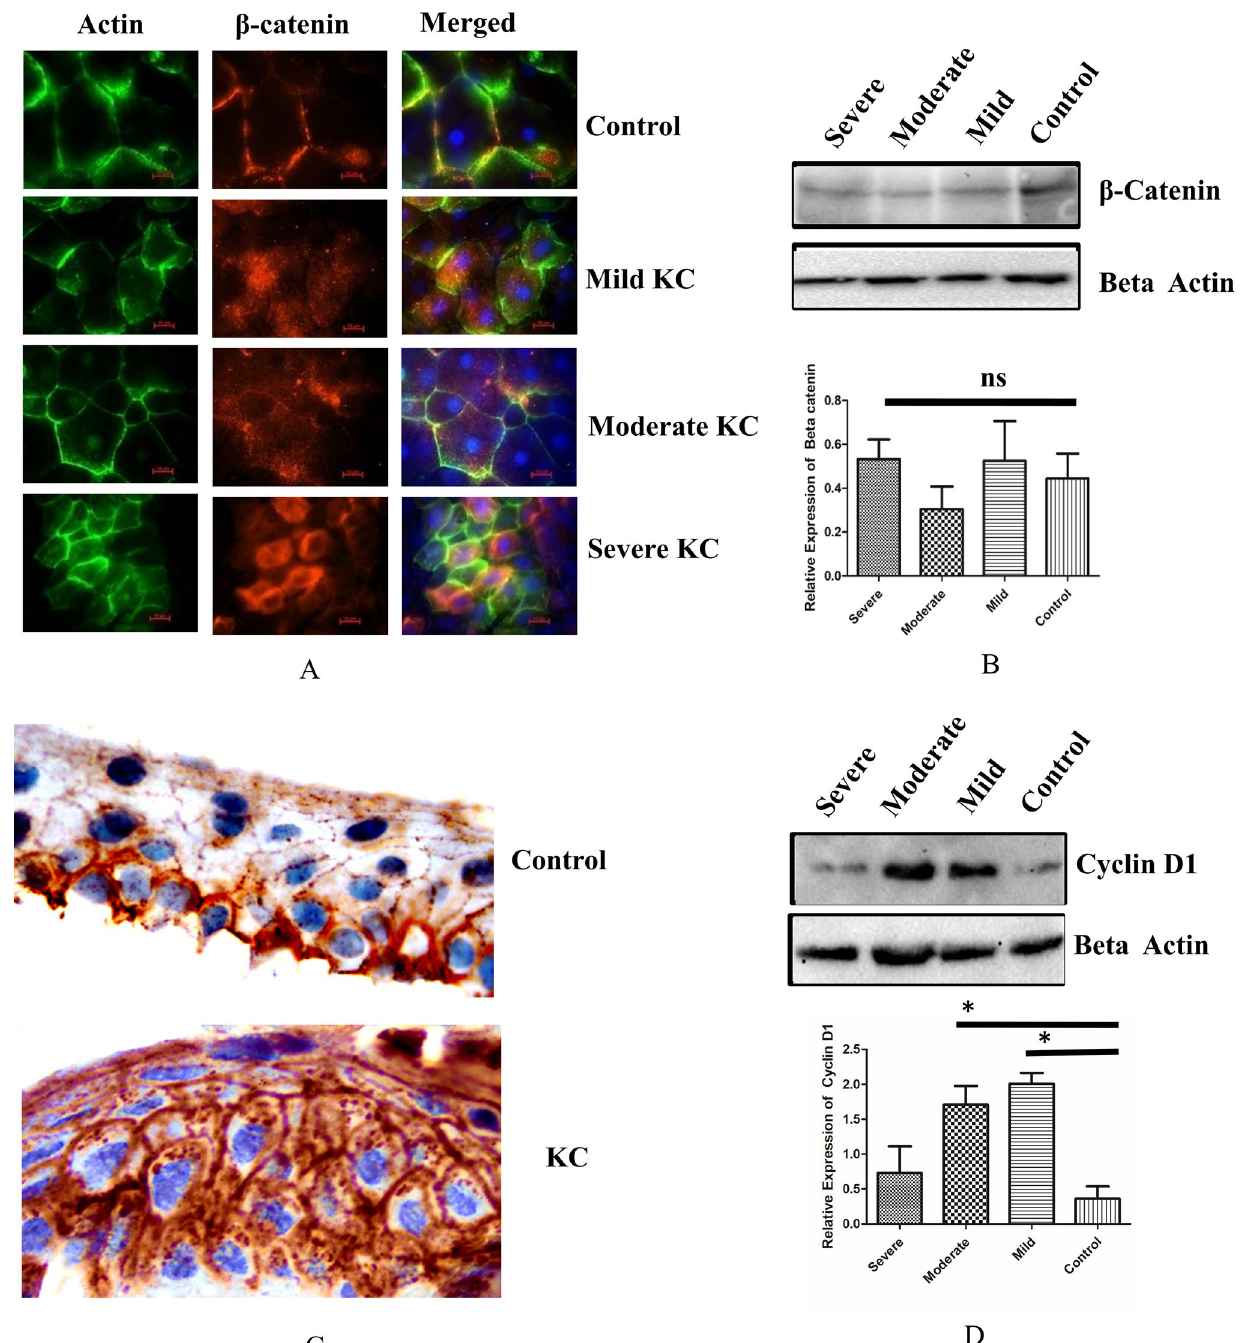
Figure 1. (A) Tissue immunofluorescence of β-catenin showing changes in localization in control, mild, moderate and severe keratoconic epithelium (n = 7) Scale bar − 10 µM. (B) Immunoblotting of β-catenin in control and KC tissues (mild, moderate and severe) (Full blot was cut in two halves for probing βcatenin and beta actin epi white merged image is represented in Fig S6). (C) Immunohistochemistry of β-catenin in control and KC tissues (n = 5). ( D ) Immunoblotting of cyclin D1 in control, and KC tissues (mild, moderate and severe) (Full blot was probed with cyclin D1 and then with beta actin, epiwhite merged image is represented in Fig S7). One way ANOVA Asterisks *, **, and *** denote a significance with p Values < 0.05, 0.01, and 0.001 respectively